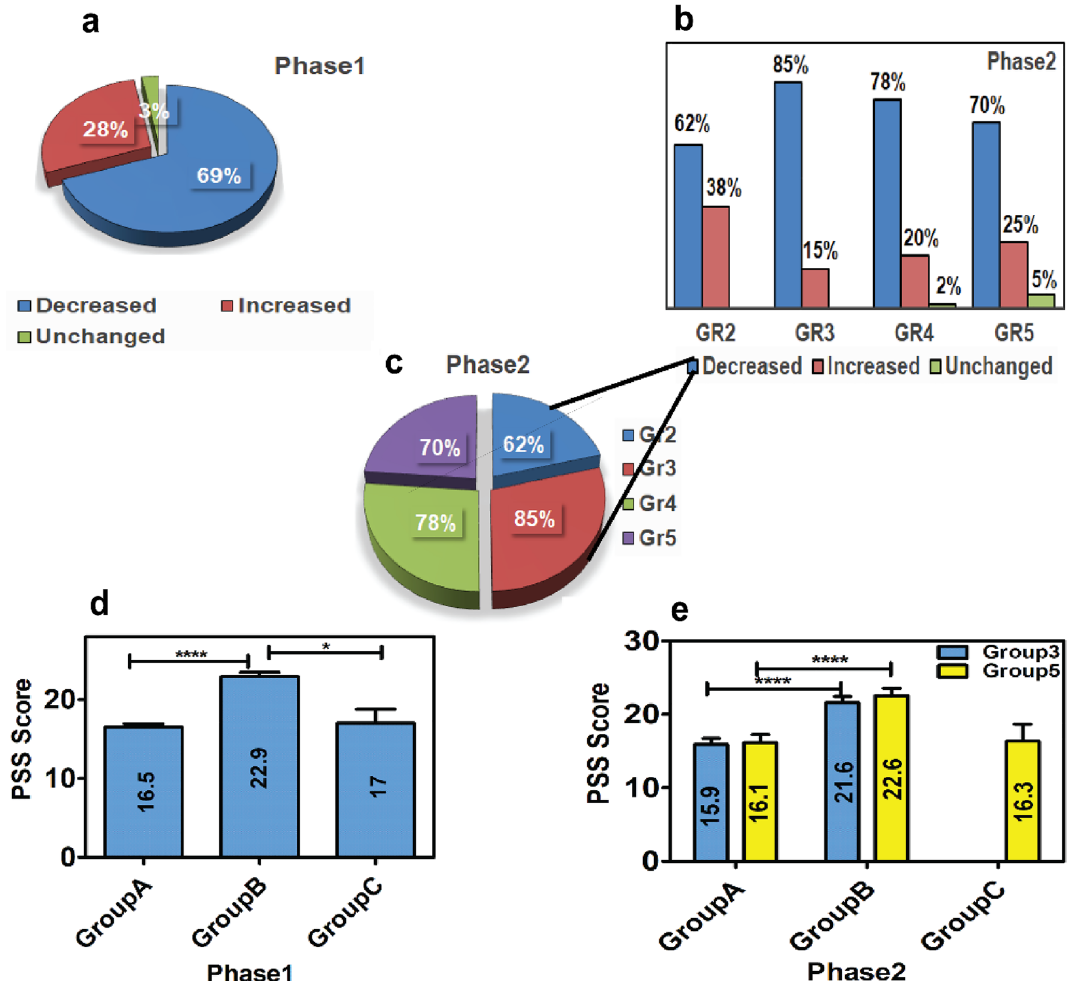
Figure 1. Graphical Illustration of the ( a ) number of participants (in percentage) showing variation in serum prolactin (PRL) level in the pooled samples of Phase 1 study, ( b ) number of participants (in percentage) showing variation in PRL level in different groups of Phase 2 study, and ( c ) number of participants showing drop in serum PRL level in different study groups of Phase 2 study. ( d ) Calculated PSS score of the patients of Phase 1 and ( e ) Phase 2 study, where Group A represents the PSS Score in group of patients with elevated serum PRL level in the subsequent samples; Group B represents the PSS score in group of patients with decreased serum PRL level in the subsequent samples, and Group C represents the PSS score in the group of patients in whom serum PRL level remains unchanged in the subsequent samples. [Results are expressed in mean ± SD; statistical significance denoted by ‘*’ corresponds to p value of < 0.05 and ‘****’ corresponds to p < 0.0001]. Prolactin level